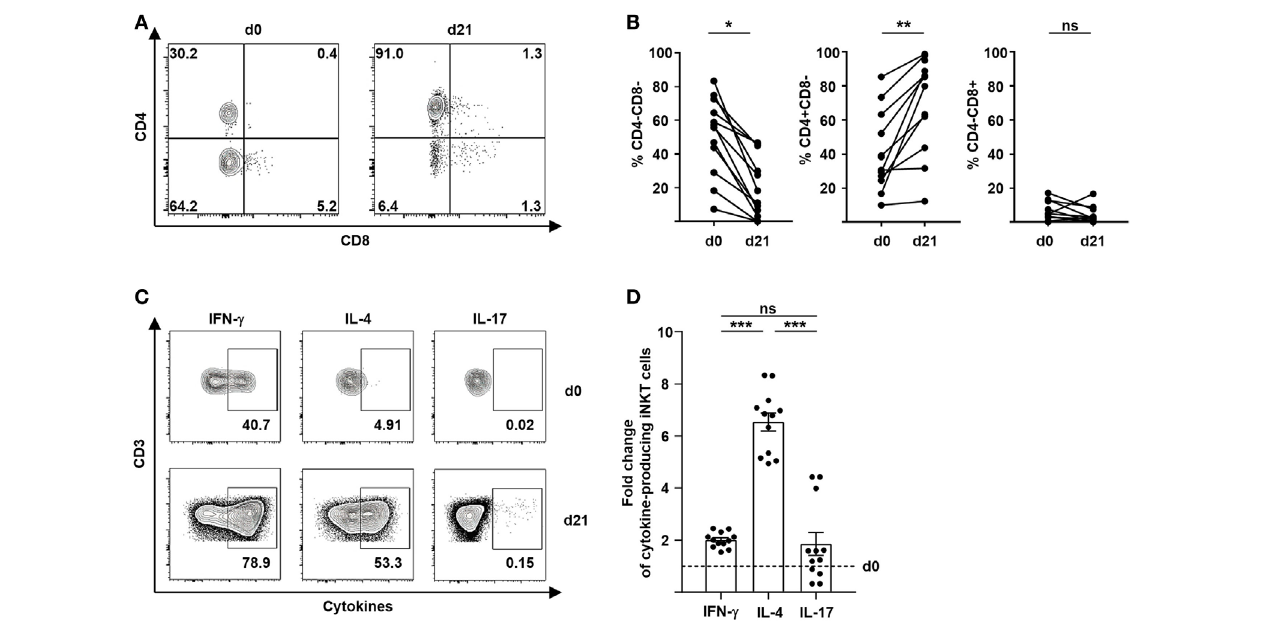
FigUre 2 | Preferential expansion of Th2-biased CD4 + invariant natural killer T (iNKT) cells. (a) Representative dot plots showing iNKT-cell subsets defined by the expression of CD4 and CD8 before and 21 days after cell culture. All events are gated on live iNKT cells. (B) Relative change of CD4 − CD8 − iNKT cells ( n = 12), CD4 + CD8 − iNKT cells ( n = 11), and CD4 − CD8 + iNKT cells ( n = 11) over 21 days of cell culture. (c) Representative dot plots showing Th1, Th2, and Th17 cytokine production of iNKT cells before and 21 days after cell culture. All events are gated on live iNKT cells. (D) Fold change of cytokine-producing iNKT cells at day 21 of cell culture compared to day 0 (dashed line) is shown for IFN- γ , IL-4, and IL-17 ( n = 12). Error bars indicate SEM, * p < 0.05, ** p < 0.01, *** p <